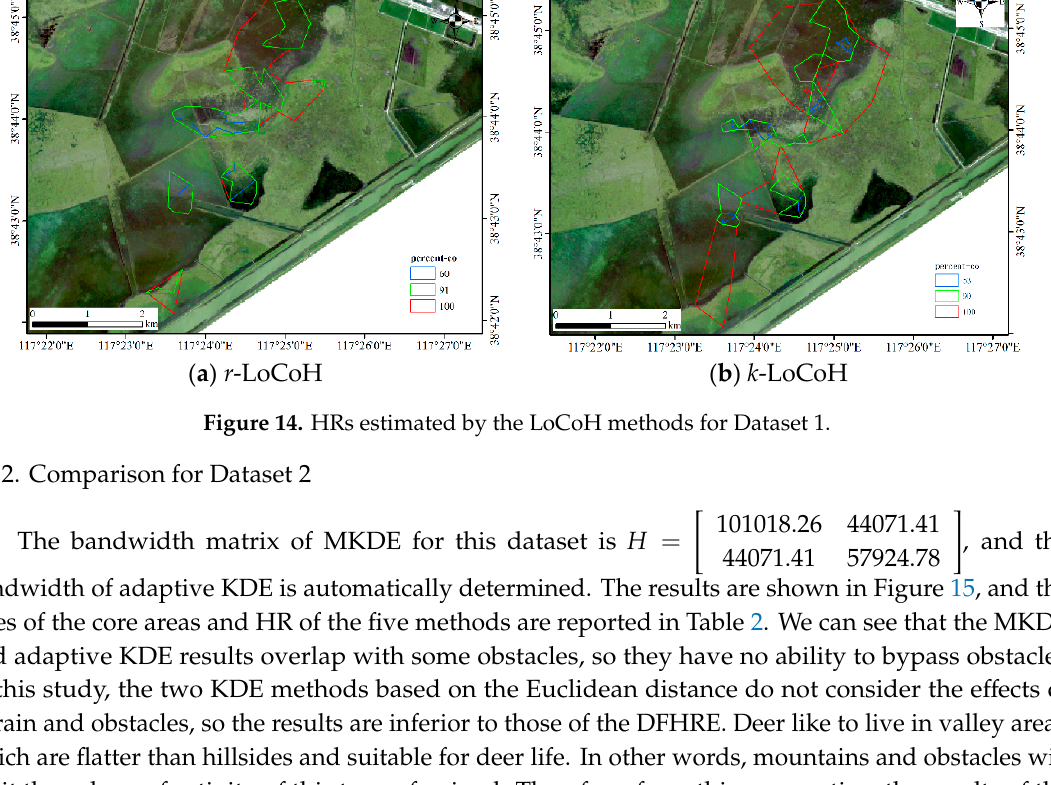
( b ) Adaptive kernel Figure 13. HRs estimated by the kernel density-based estimator (KDE) methods for Dataset 1. Table 1. Sizes of the core areas and HRs estimated by the DFHRE, KDE and LoCoH methods for Dataset 1.